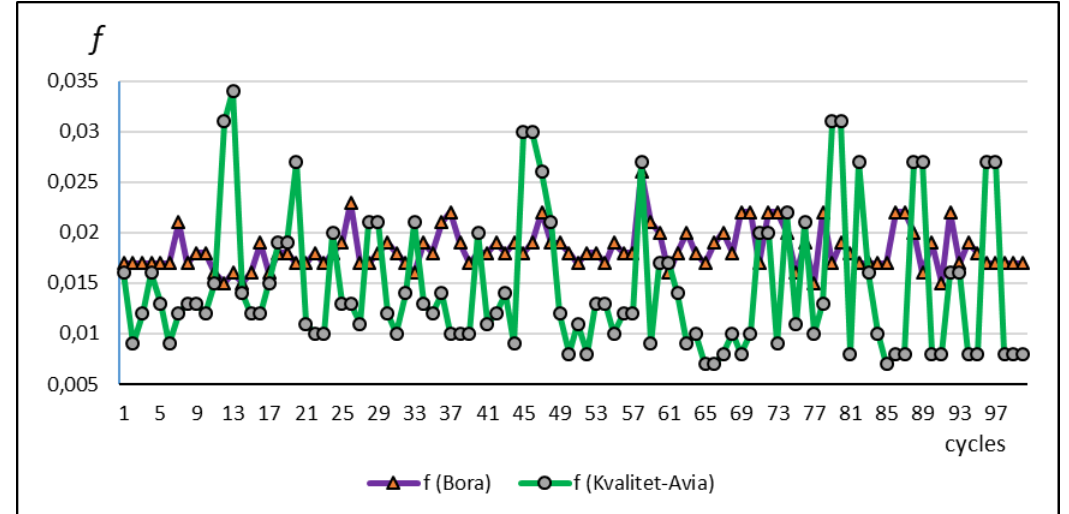
Fig. 2. The kinetics of change in the friction coefficient